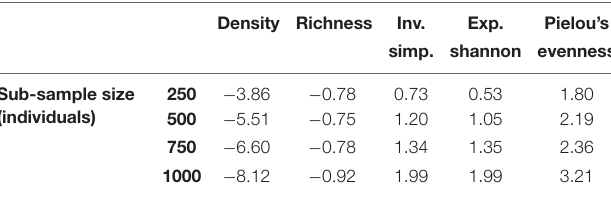
TABLE 5 | Cohen’s d , a measure of effect size, for the (25n + 26a) treatment, for five different metrics across four sub-sample sizes. Density Richness Inv. Exp. Pielou’s simp. shannon